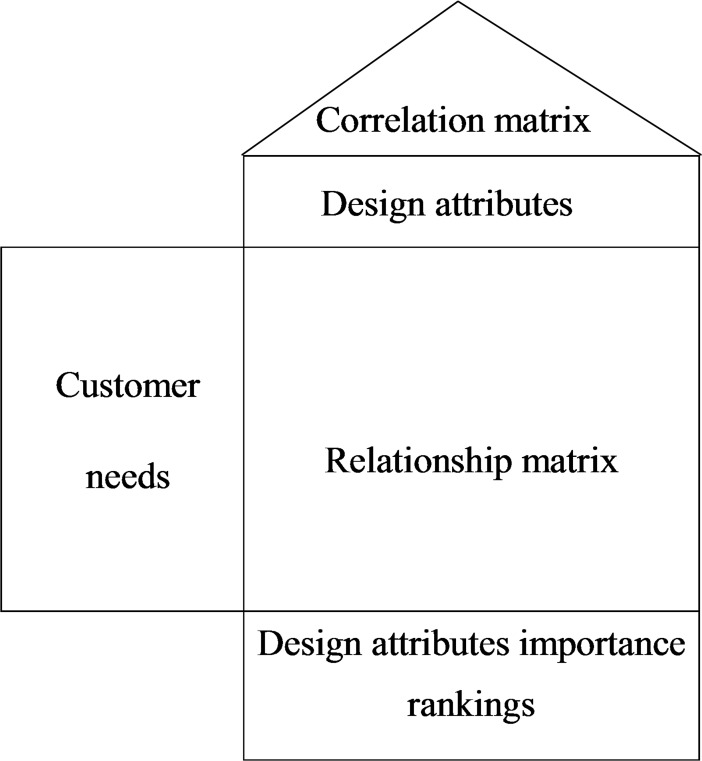
House of quality.